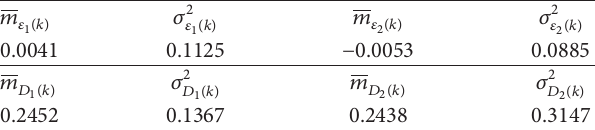
Table 1: Statistical average values of the interconnected